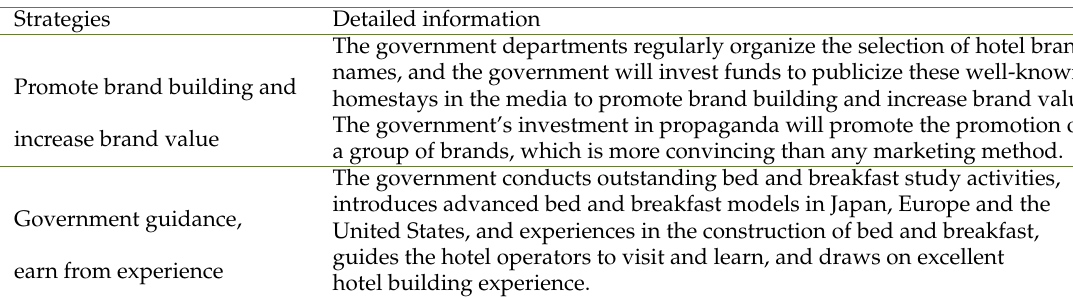
Table 1. Strategies of